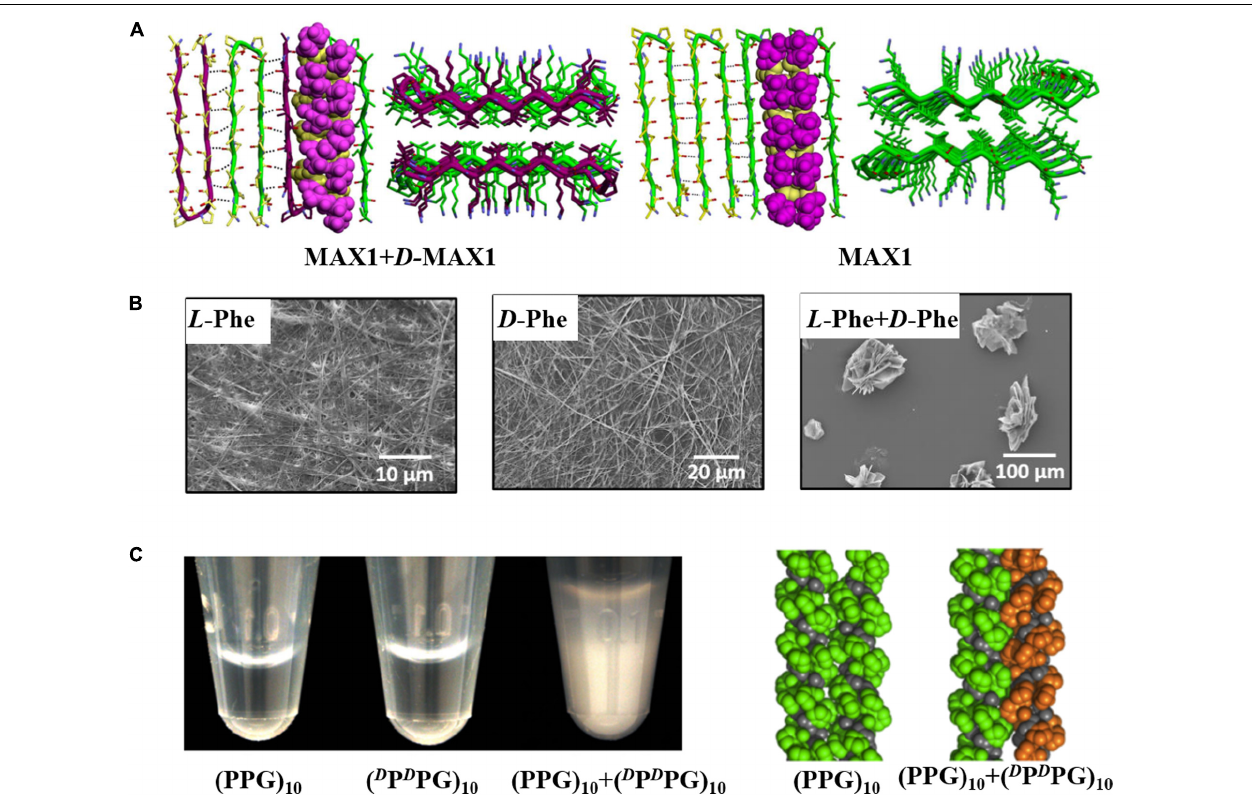
FIGURE 2 | Co-assembly structures of racemic peptides and amino acids. (A) Model of MAX1/ D -MAX1 in their co-assembled structure and model of pure MAX1 in its self-assembled structure. Reproduced with permission from Nagy-Smith et al. (2017). Copyright 2017 American Chemical Society. (B) The co-assembly structure of L -Phe and D -Phe is totally different from the self-assembly structure of the pure enantiomers. Reproduced with permission from Bera et al. (2020). Copyright 2020 American Chemical Society. (C) Mixing (PPG) 10 and ( D P D PG) 10 drastically lowered the solubility and packing model of (PPG) 10 self-assembled structure and (PPG) 10 /( D P D PG) 10 co-assembled structure. Reproduced with permission from Xu et al. (2013). Copyright 2013 American Chemical